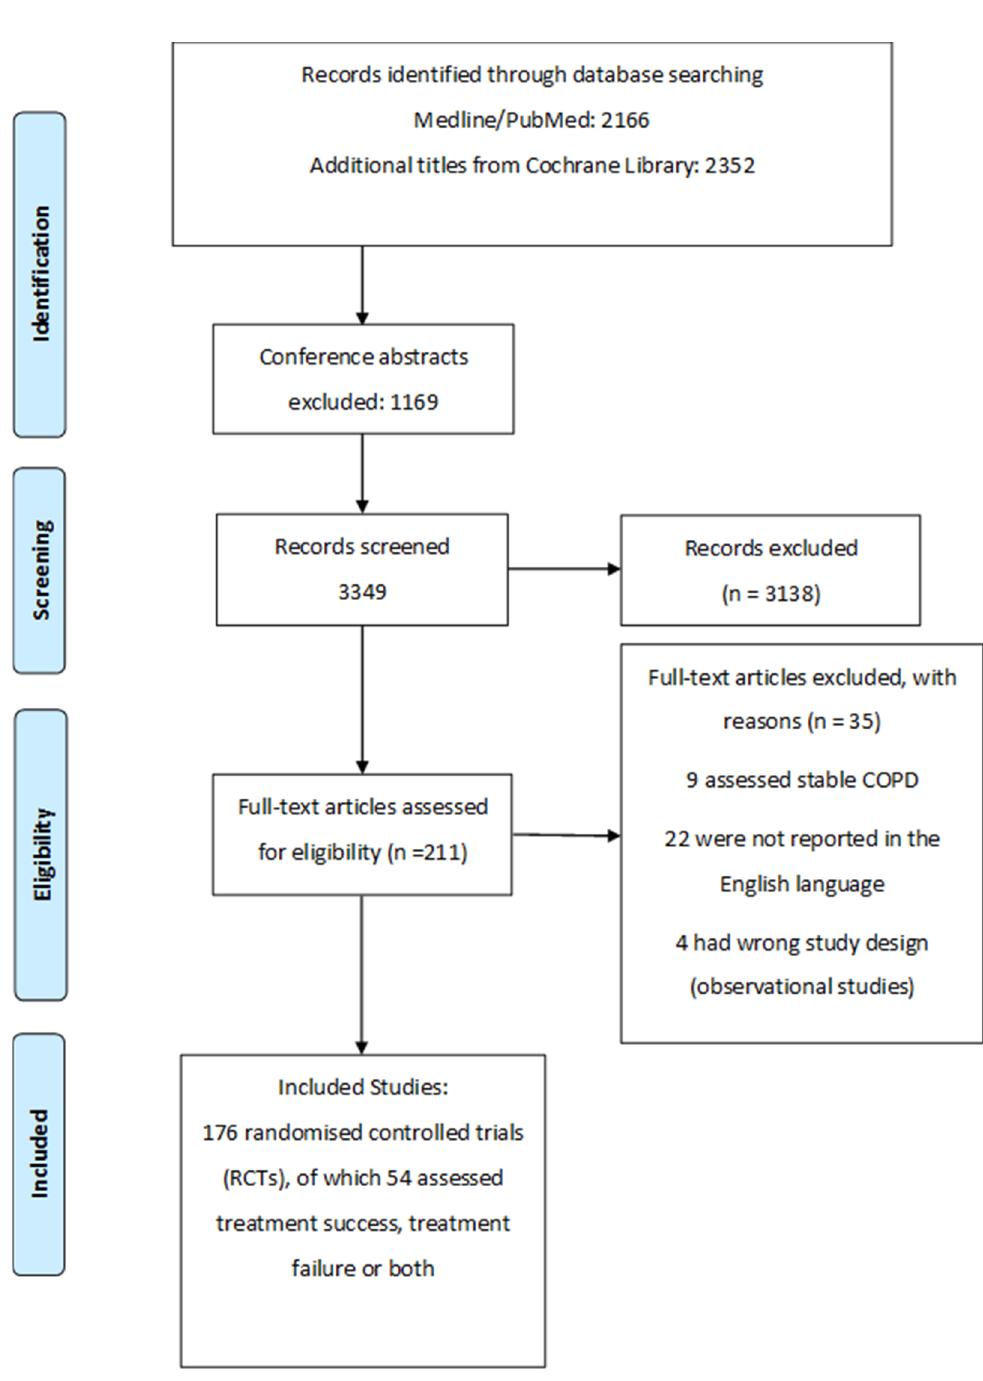
Figure A1. PRISMA Flowchart.